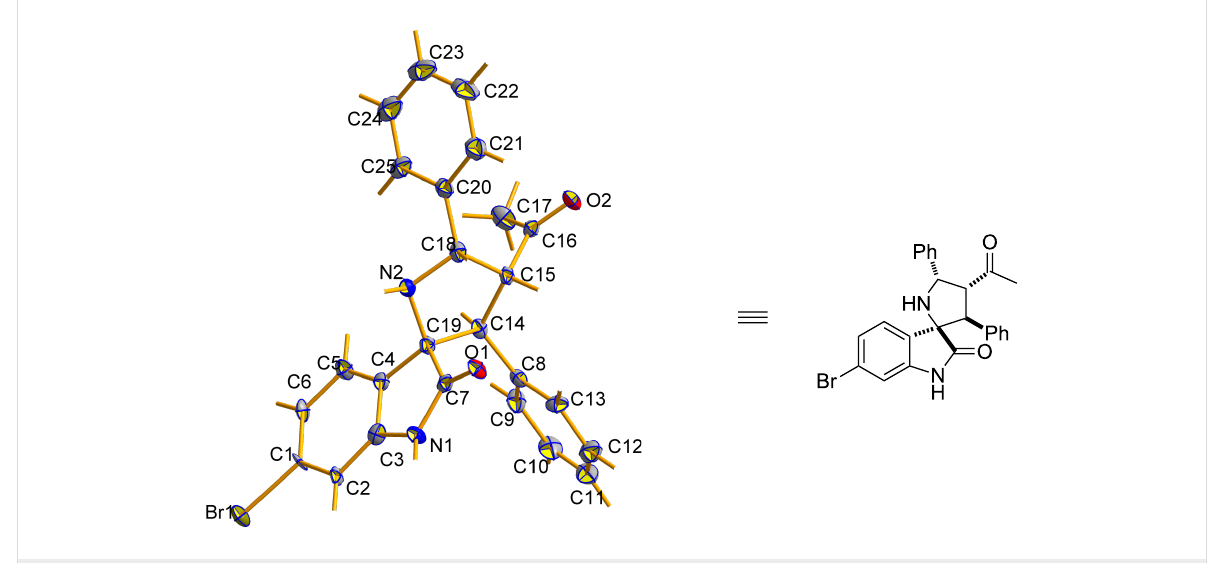
Figure 2: ORTEP diagram of 5e .